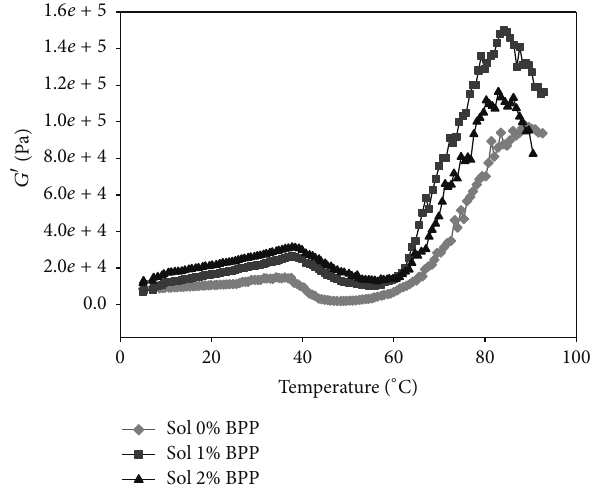
Figure 6: Effect of addition of BPP on changes in the storage modulus ( 𝐺 󸀠 ) during heating of sols from giant squid ( Dosidicus gigas